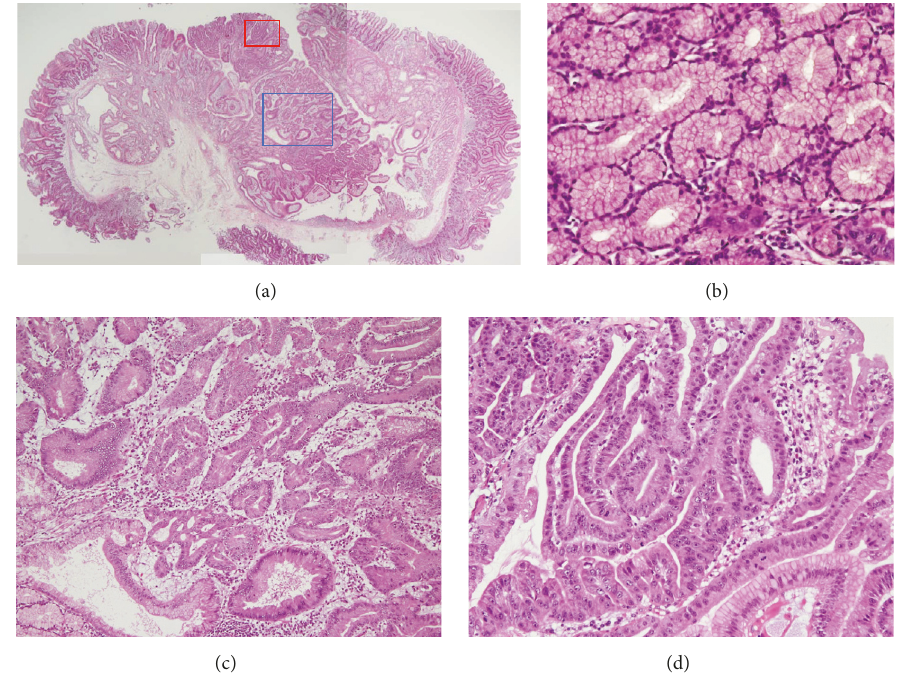
Figure 4: Histopathological images. Proliferation of Brunner’s glands is seen in the resected specimen (a: × 2, b: × 20). Gastric foveolar metaplasia is also identified (a: blue square, c: × 10). Atypical cells with pleomorphic macronuclei with dense chromatin forming irregular glandular structure are found in the superficial layer (a: red square, d: × 20). Hematoxylin and eosin